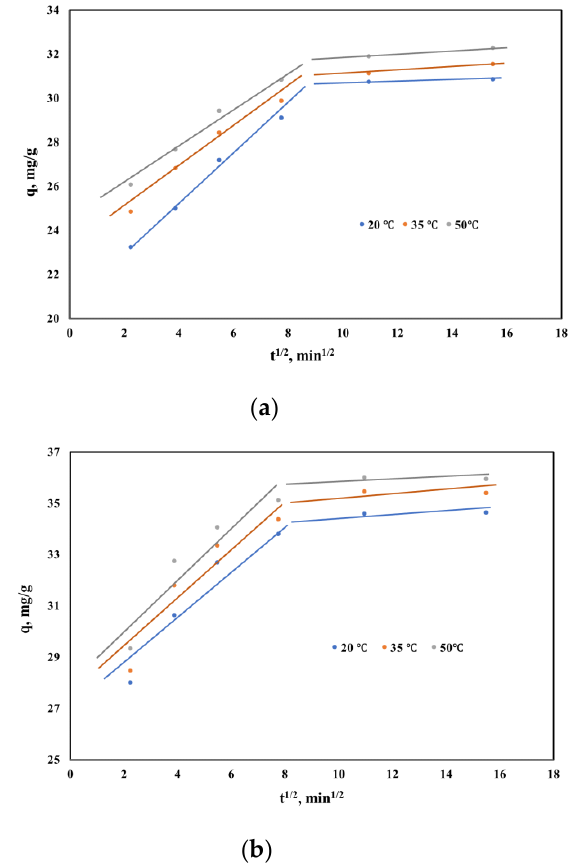
Figure 8. Intraparticle di ff usion model of MoO 42 − adsorption onto ( a ) Mg 4 Fe and ( b ) Mg 4 Fe-450.